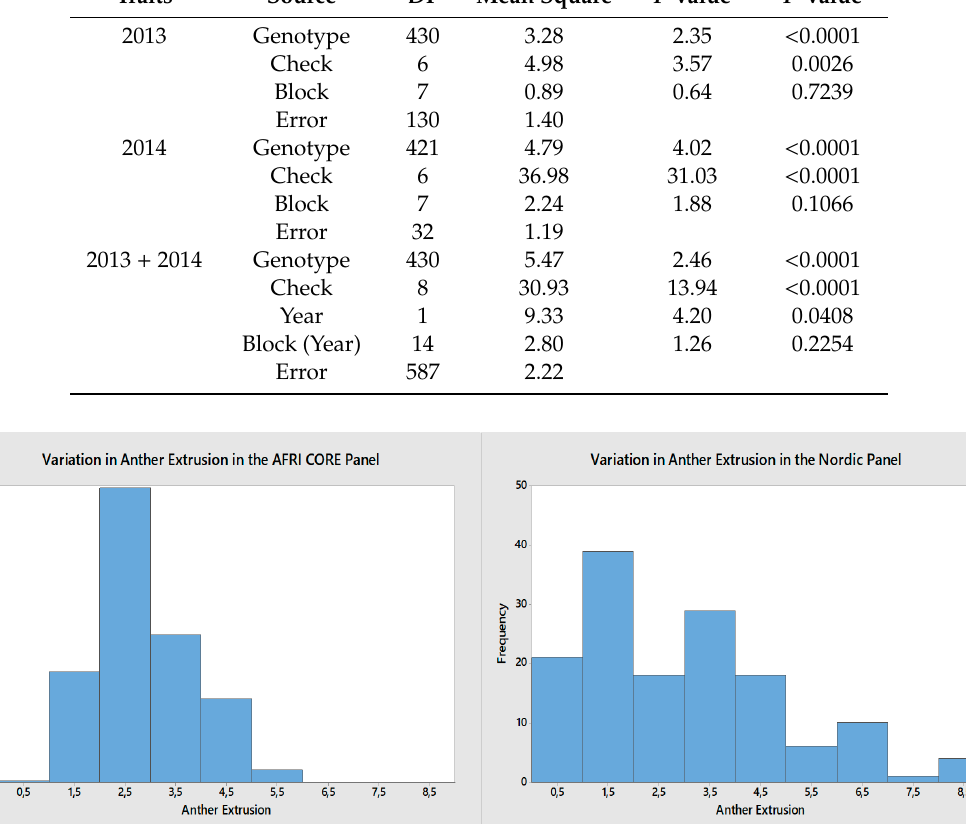
Figure 1. Distribution of BLUP values for anther extrusion in the North American AFRI CORE oat screening panel ( Left) and the Nordic oat screening panel ( Right ). Anther extrusion was scored on a 0–9 scale. Note the more limited range in the AFRI CORE.